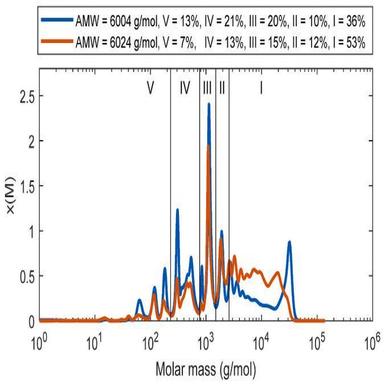
Differential log molecular weight distribution, x(M), of poultry hydrolysates, derived from size exclusion chromatography. The plot shows two hydrolysates with approximately equal average molecular weight (AMW) but different weight distributions (MWD). The distributions are divided into five molecular weight regions (I-V) as in Ref., and the relative weight proportion of each fragment is calculated from the cumulative weight distribution.